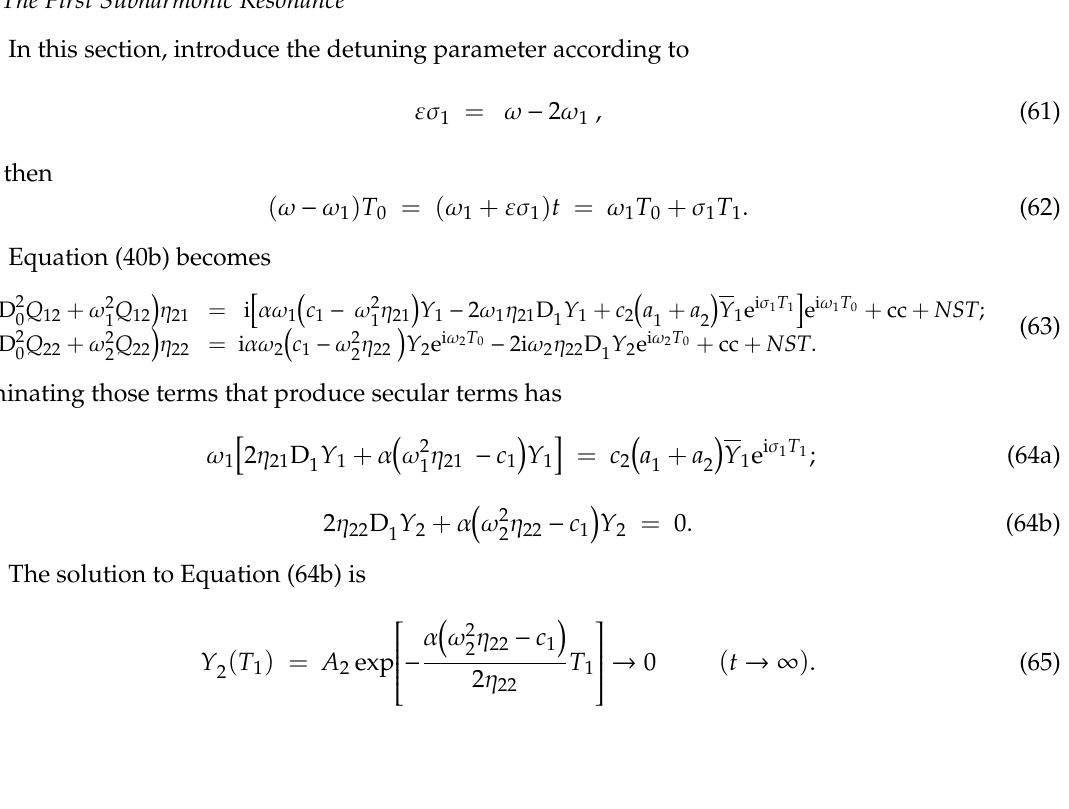
Figure 6. The large-amplitude periodic response when ω = ω 2 − ω 1 : ( a ) initial history; ( b ) steady-state response; ( c ) phase diagram; ( d ) Poincare map. The solid blue dots stand for analytical prediction and others for numerical simulation.